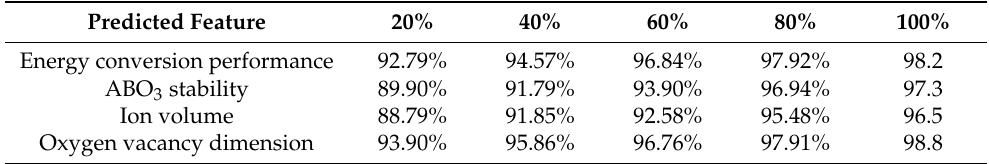
Table 5. Precision for various parts of the target